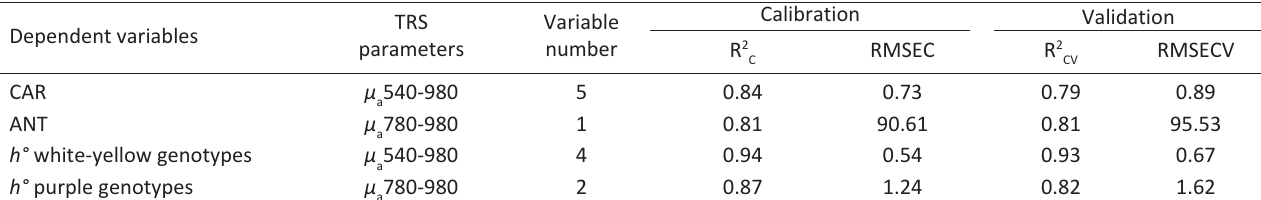
Table 4 ­ Performance of PLS regression models on original TRS absorption spectral data for prediction of total carotenoids (CAR) and